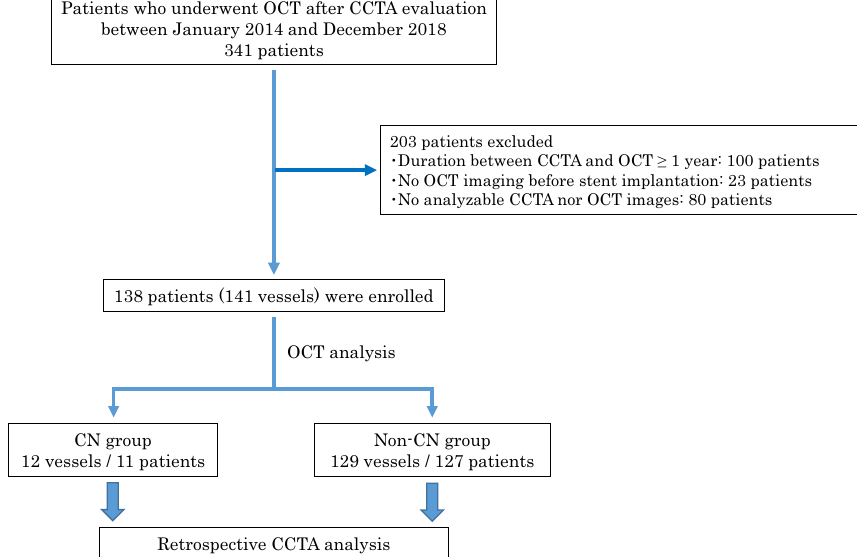
Figure 1. Study flow chart. CCTA coronary computed tomography angiography, CN calcified nodule, OCT optimal coherence